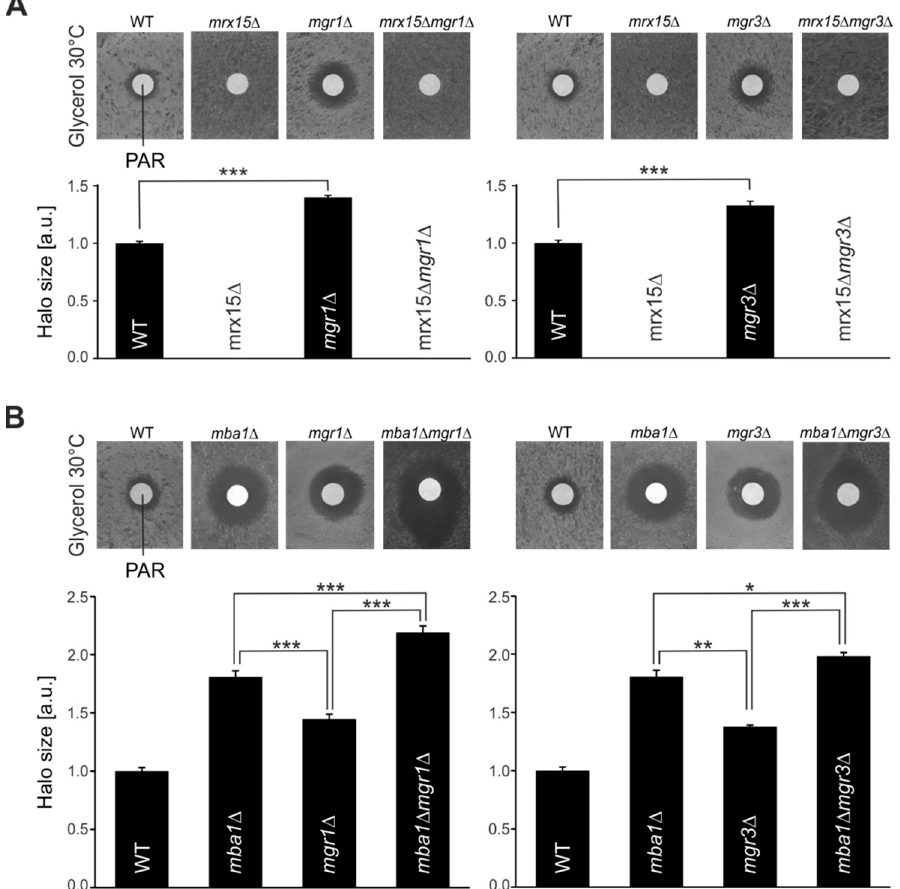
Figure 3. MGR1 and MGR3 are required during proteotoxic stress. ( A ) and ( B ) Disk diffusion assays of indicated strains. Sensitivity against 1 mM paromomycin (PAR) was tested by plating cells on respiratory media (glycerol) and adding the antibiotic. Halo diameters of three independent experiments were quantified. Significance of observed changes was assessed by a student’s t -test (* p ≤ 0.05, ** p ≤ 0.01, *** p ≤ 0.001).